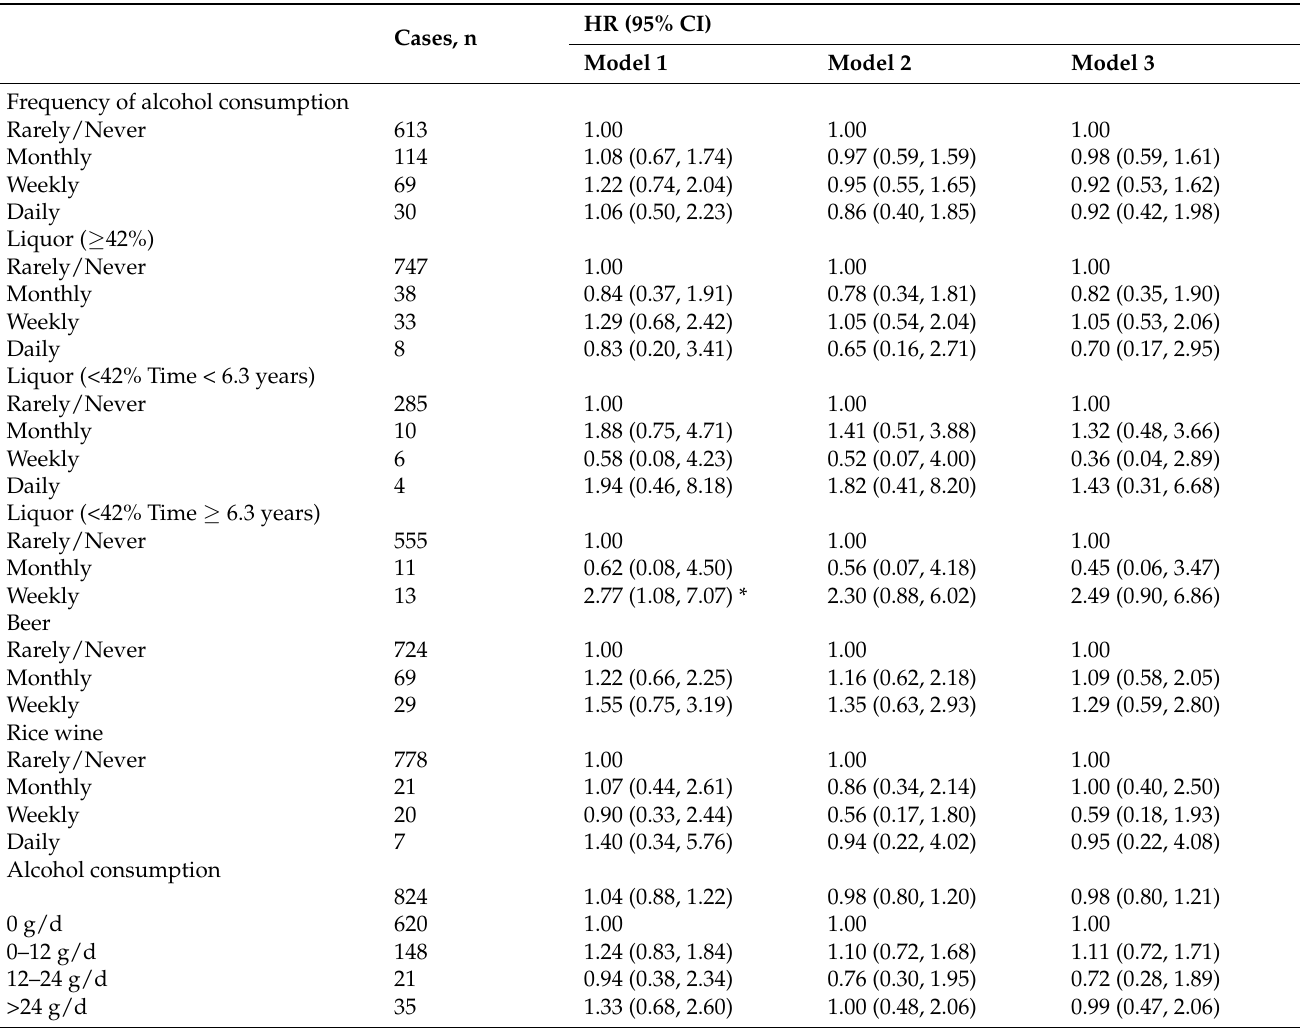
Table 4. Hazard ratios (95% confidence intervals) of hypertension associated with drinking among the unemployed and retired. HR (95% CI) Cases, n Model 1 Model 2 Model